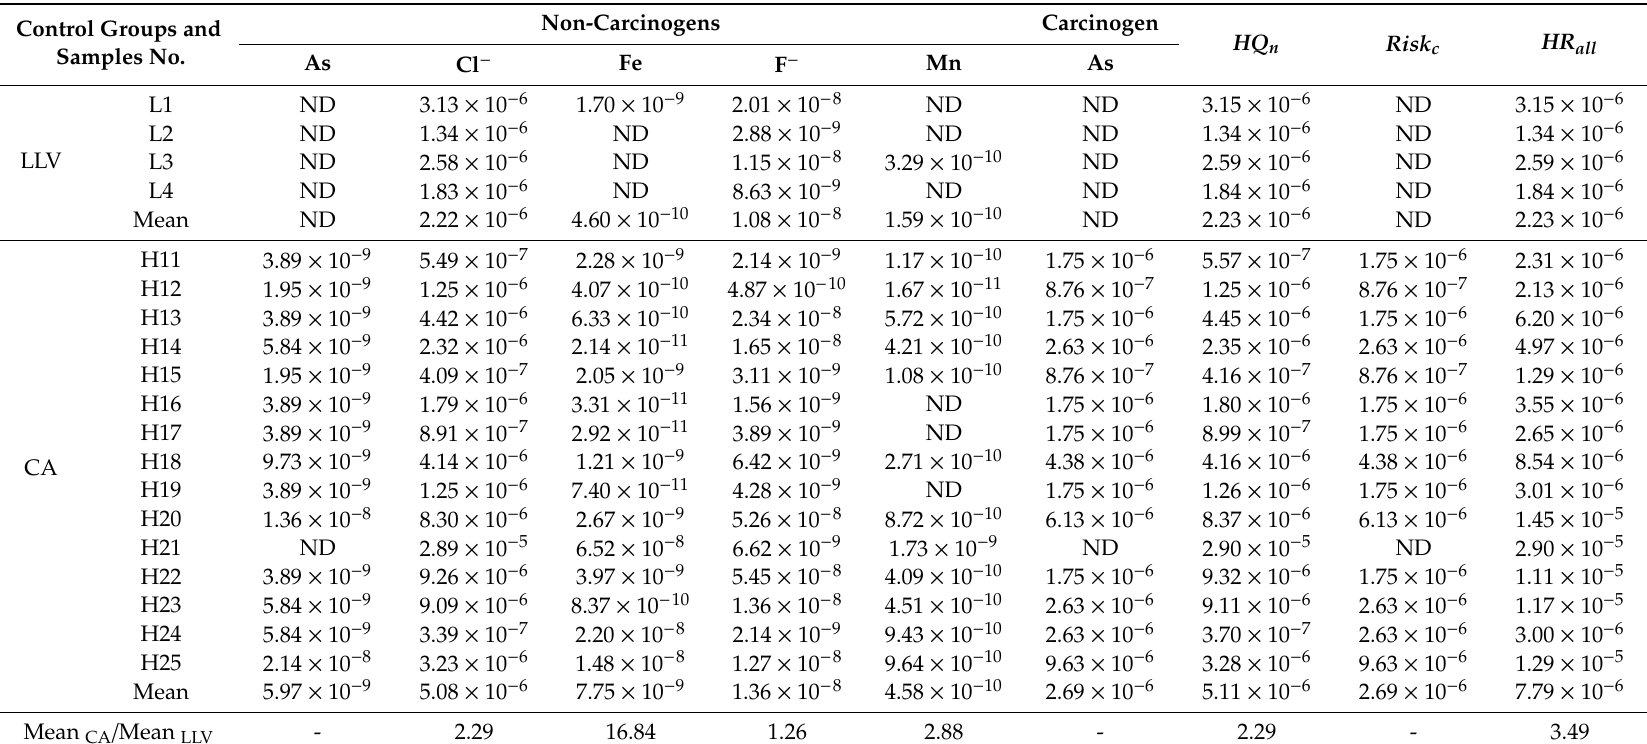
Table 9. Human health risk assessment result of LLV and CA (per year). Control Groups